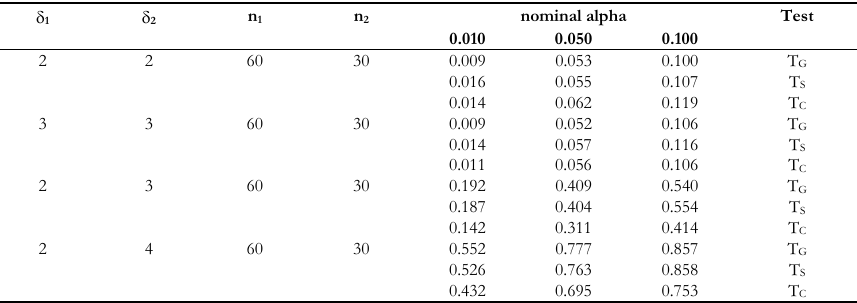
Rejection rates for the two-sided tests in the null and alternative